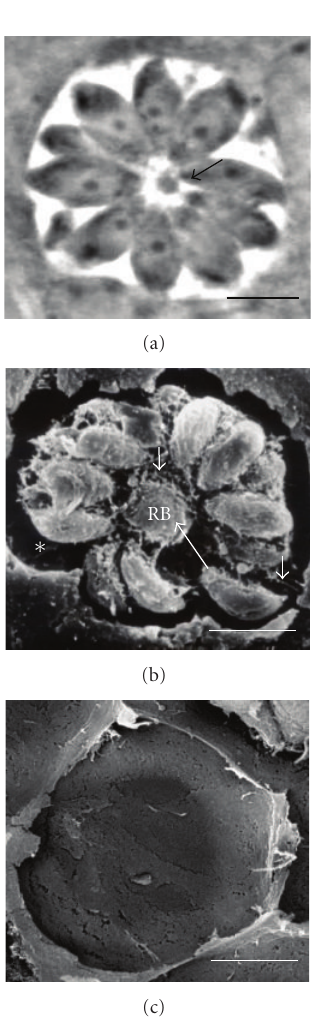
Figure 1: Intravacuolar organization of tachyzoites in MDCK cells. (a) Phase contrast micrograph of a rosette of intravacuolar tachyzoites and (b) SEM-Tanaka micrographs of a rosette (B). Long arrows indicate the RB; arrowheads show intravacuolar network extensions connecting parasites to the PVM; short arrows indicate the position of the apical end in tachyzoites; asterisks show the empty space observed around parasites, at the periphery of the PV. The counterpart of the PV was devoid of any material from the MNN or of tachyzoites (c). Bar = 5 µ m.